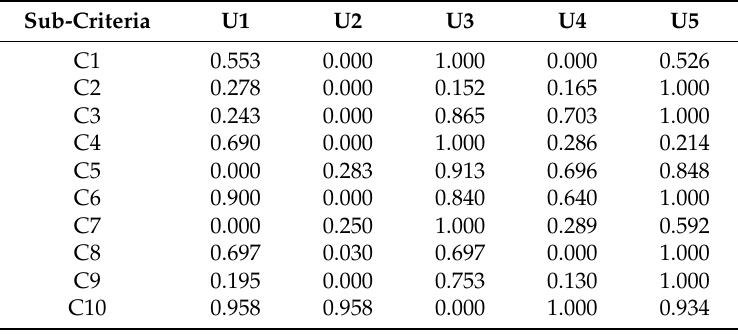
Table 21. The standardized distances for five alternatives on each